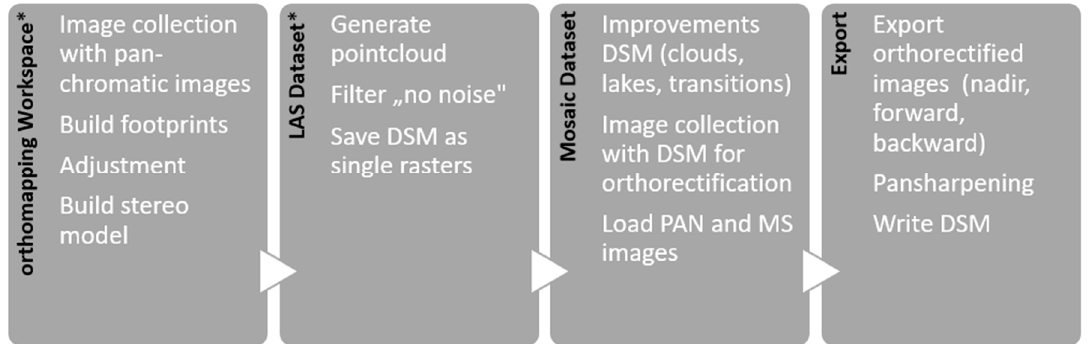
Figure 2. Step-by-step processing of the digital surface model (DSM) and the orthophoto with ESRI ArcGIS Pro 2.01. * calculation step individually per scene.